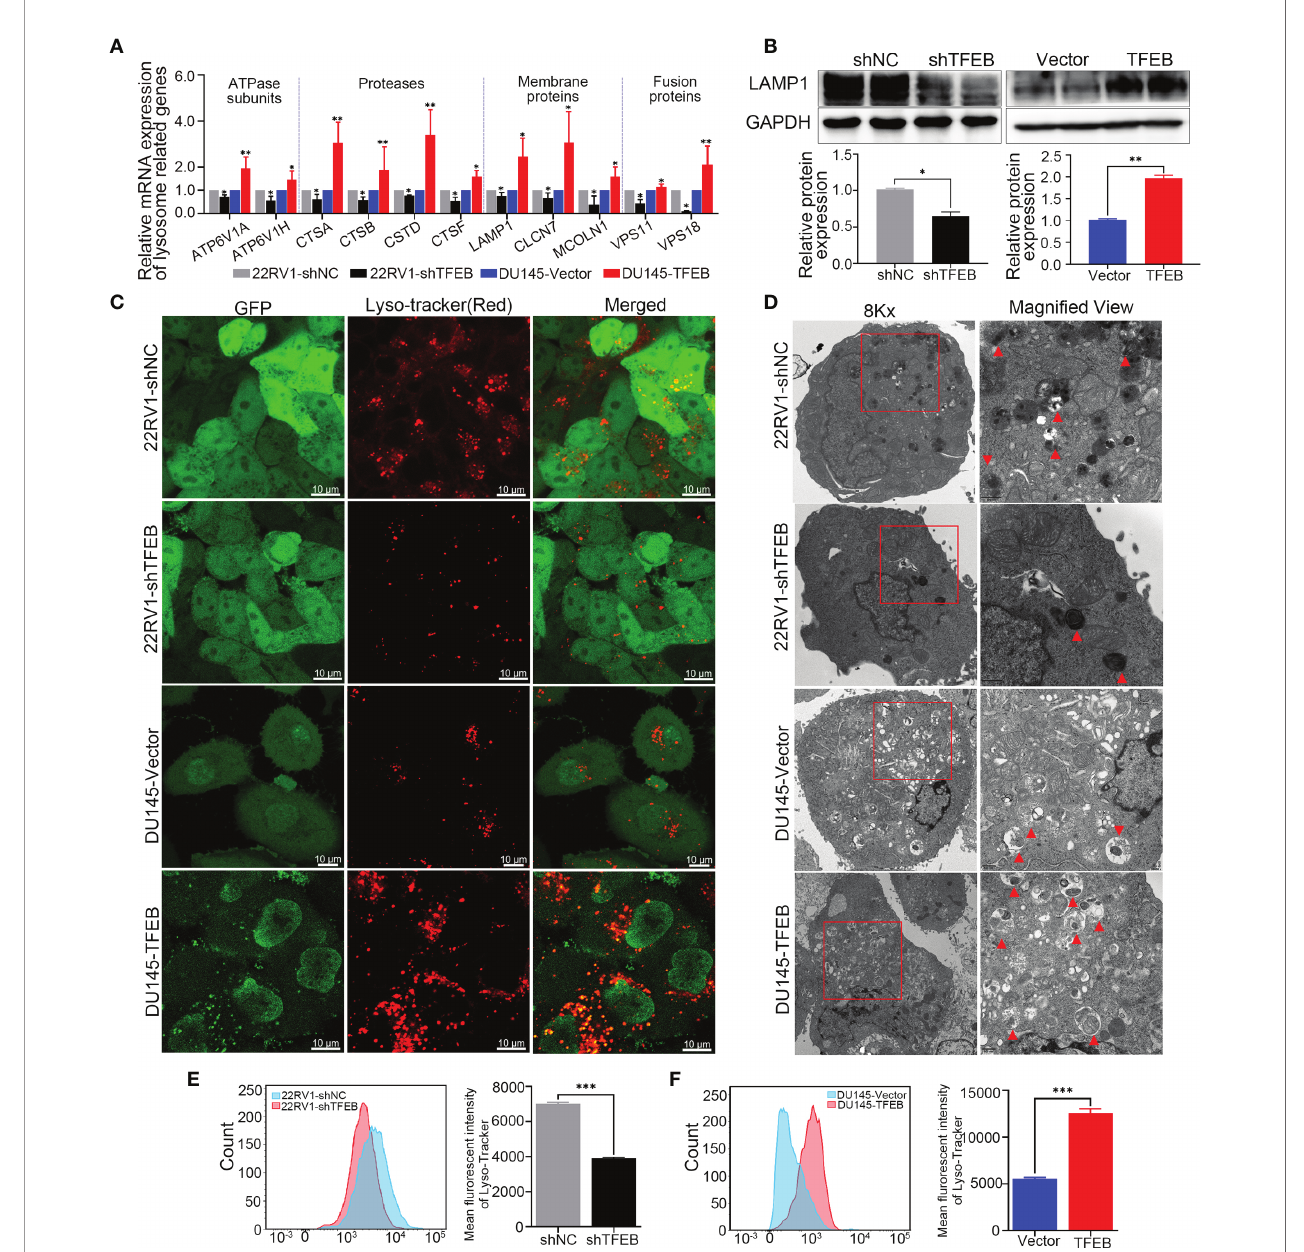
FIGURE 4 | Overexpression of TFEB induced lysosome biogenesis in PCa cell. Knockdown TFEB expression decreased lysosome biogenesis in PCa. (A) Validation of lysosome related genes by qRT-PCR in different PCa cell lines. (B) Validation of lysosome marker protein LAMP1 by western-blot in different PCa cell lines. Quantitative analysis of the western-blot shows LAMP1 expressed signi fi cantly differently in TFEB-overexpressing or TFEB knockdown cell lines. (C) PCa cells were treated with Lyso-Tracker Red DND-99 (50 nM) for 45 min. (D) Transmission electron microscope (TEM) image of lysosomes or autophagosomes in PCa cells. (E, F) The quantitative measurement of Lyso-Tracker Red DND-99 (50 nM) was performed by fl ow cytometry. Statistical analysis was from three independent experiments and is presented as mean ± SD. * p < 0.05, ** p < 0.01, *** p < 0.001 compared with control